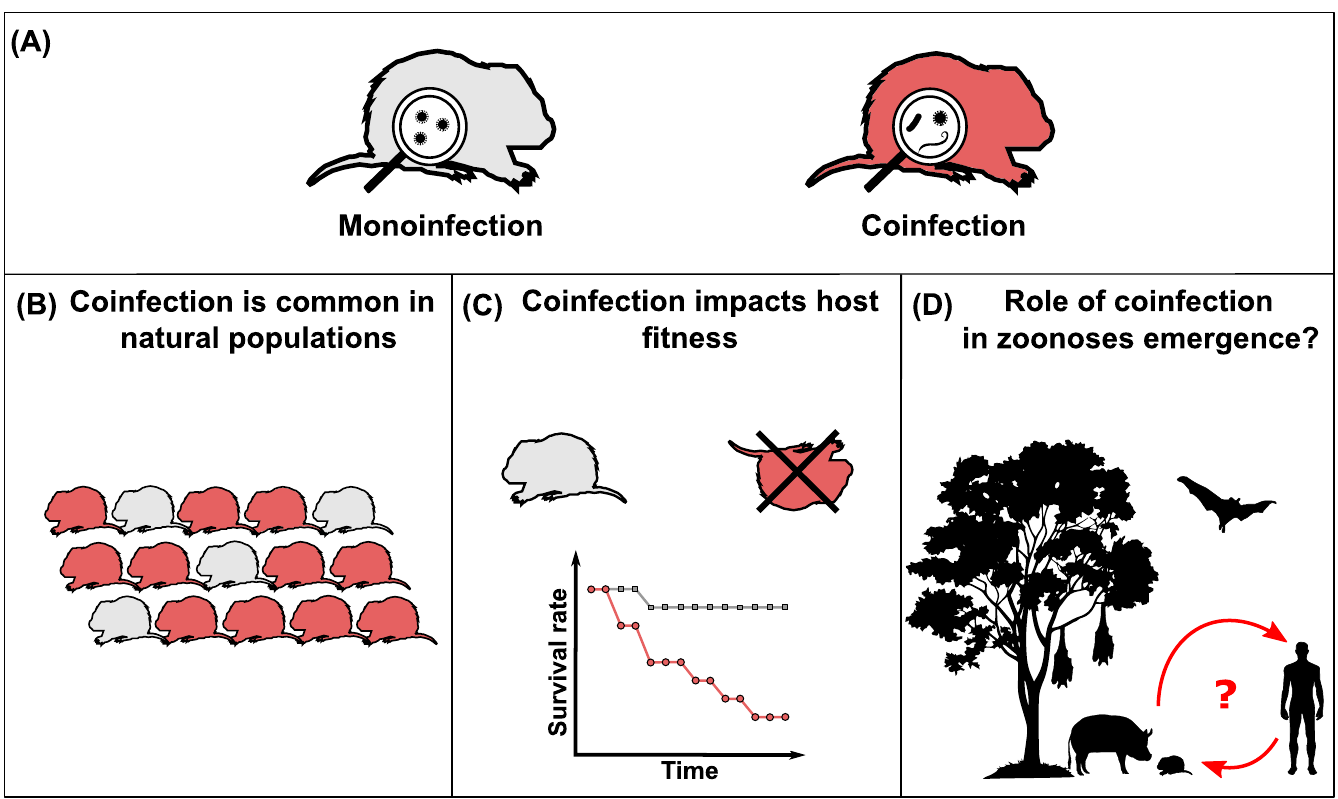
Fig 1. The importance of coinfection in wild hosts. (A) Coinfections are defined by the presence of at least two genetically different infectious agents in the same host: infectious agents of different taxonomic levels (e.g., bacterium and virus) but also genetic variants of the same infectious agent (e.g., virus genotypes). (B) Coinfection is the rule in all living communities and prevalence can be high in vertebrate animals. (C) Coinfection can impact host fitness. (D) The importance of coinfection in zoonoses emergence processes remains to be fully